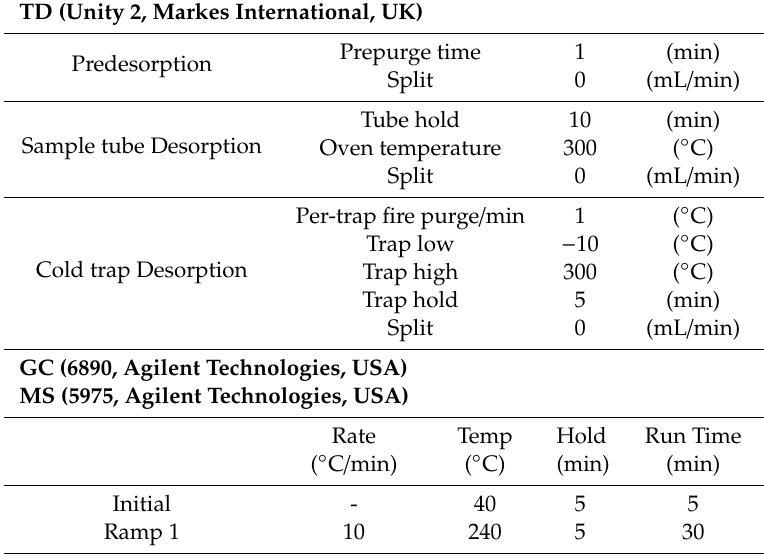
Table 2. Operating parameters of thermal desorber (TD) and gas chromatography (GC) / mass spectrometer (MS). TD (Unity 2, Markes International, UK) Prepurge Predesorption